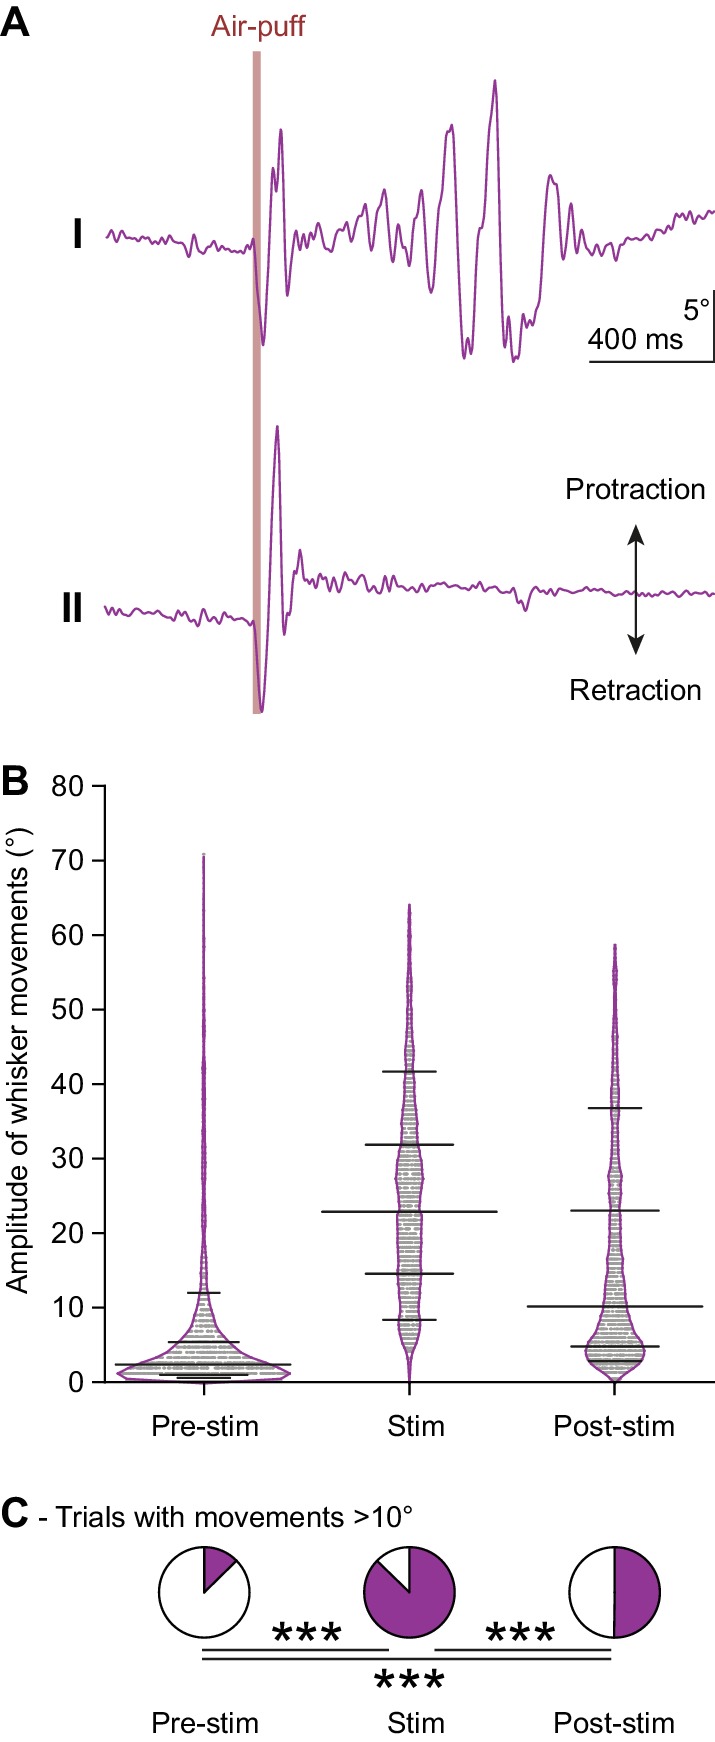
Whisker movements are largely restricted to the period after the air-puff.(A) During a prolonged period of 0.5 Hz whisker pad stimulation, in roughly half the trials the stereotypic whisker movement – retraction followed by a large active forward sweep – is followed by a prolonged period of more variable whisker movements. The traces show here the whisker movements (averaged over all trackable whiskers) during the two trials marked ‘I’ and ‘II’ in Figure 1D. (B) Violin plots showing the amplitudes (difference between maximal retraction and maximal protraction in three 200 ms interval (relative to the start of the air-puff: −200–0 ms (Pre-stim), 0–200 ms (Stim) and 200–400 ms (Post-stim))) of individual trials of 16 mice (with approximately 100 trials per mouse). Horizontal lines represent 10th, 25th, 50th, 75th and 90th percentiles. (C) Fractions of trials with movements exceeding 10°. Asterisks indicate significantly different fractions of trials with movement. ***p<0.001 (χ2 = 1470.24; 3 × 2 χ2 test).